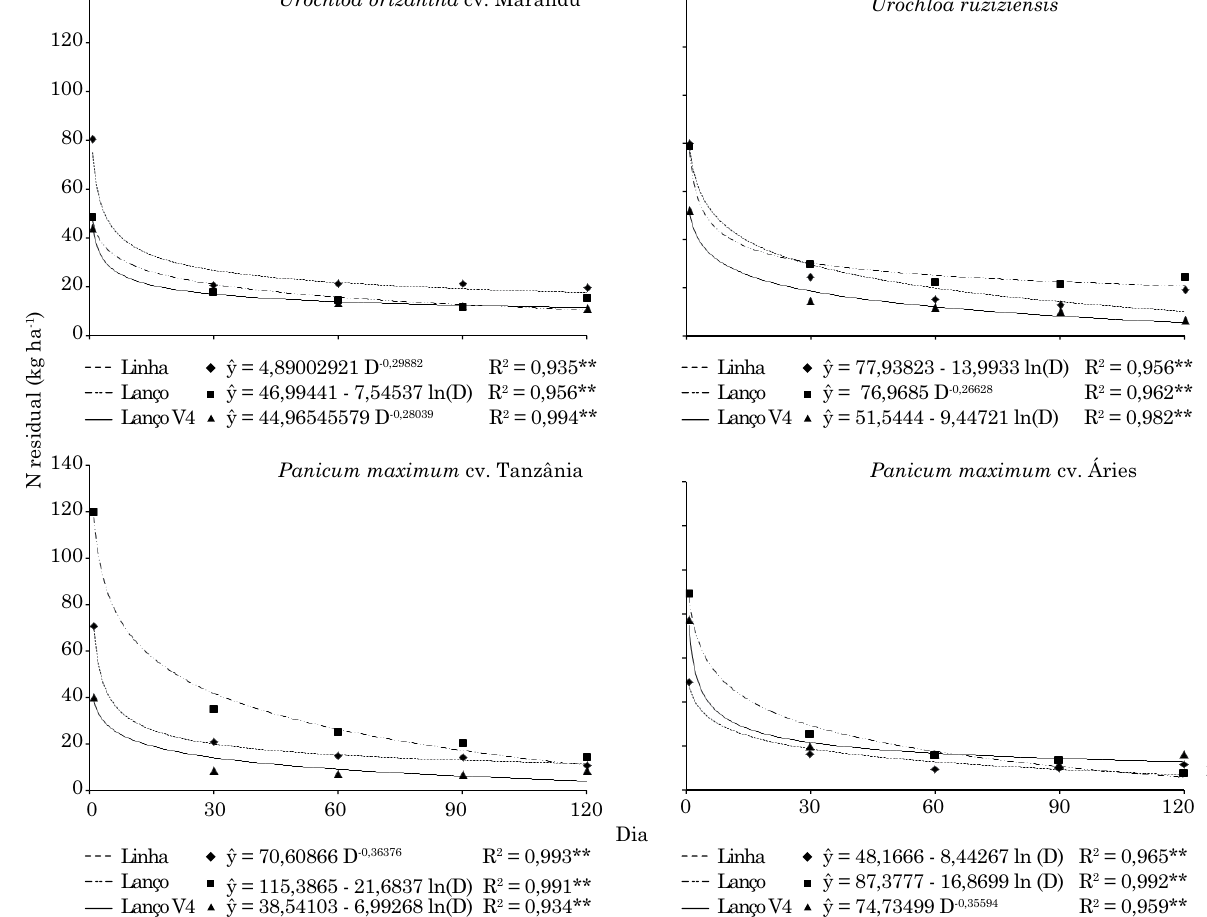
Figura 2. Nitrogênio residual na palhada das forrageiras remanescente no solo até 120 dias durante o cultivo da soja, para as condições das forrageiras semeadas no plantio do milho, na linha (Linha) ou a lanço (Lanço) ou no estádio V4 a lanço (LançoV4). ** e * p<0,01 e <0,05,